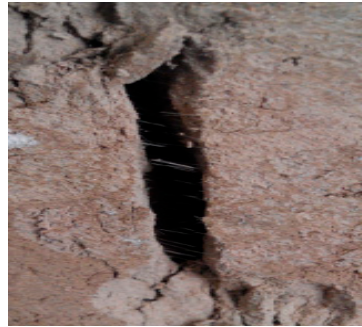
Figure 5. Failure characteristic of cement soil reinforced with basalt fiber.